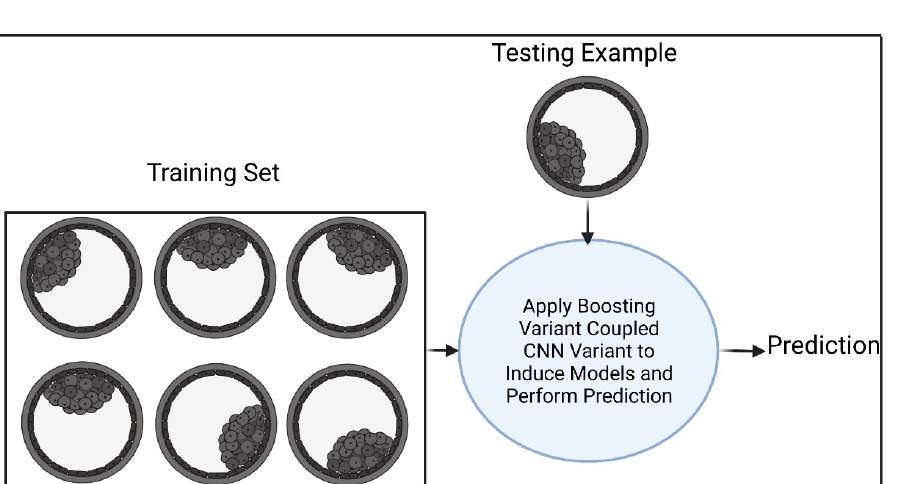
Figure 4. The architecture of the CNN variant that is utilized via the proposed approach DL.